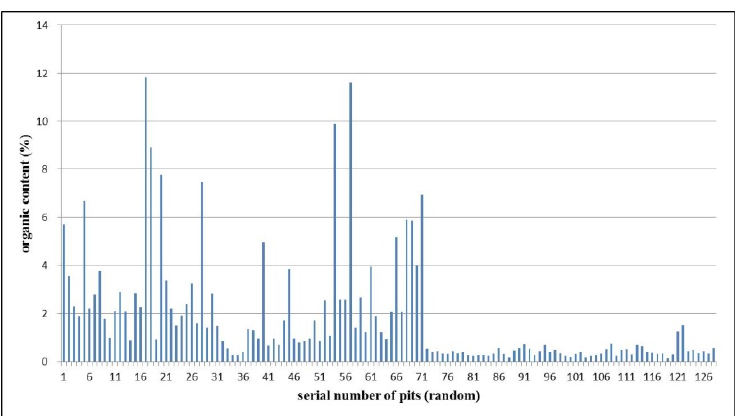
Figure 12. Active-layer soil organic content variation on the Qinghai–Tibet plateau.